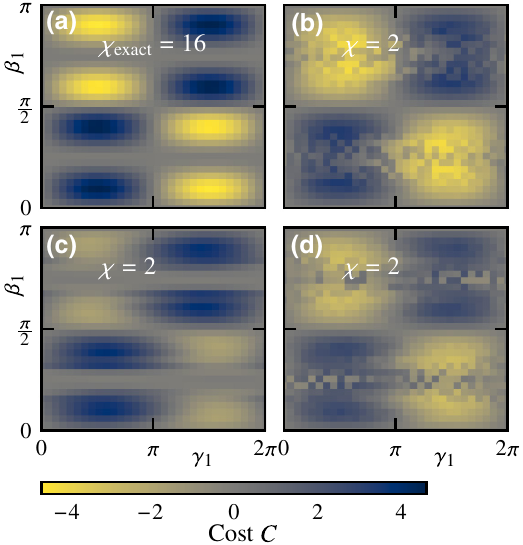
FIG. 11. The cost landscape for the N = 8 unit-weight 3- regular graph of Fig. 5(f) versus the two parameters γ 1 and β 1 of a one-layer QAOA circuit. (a) An exact simulation with χ = 16. (b)–(d) An approximate simulation with χ = 2. The mapping from the graph to the one-dimensional topology of the MPS is different in (b)–(d). One observes that the truncation to keep χ = 2 affects the landscape differently depending on the mapping.